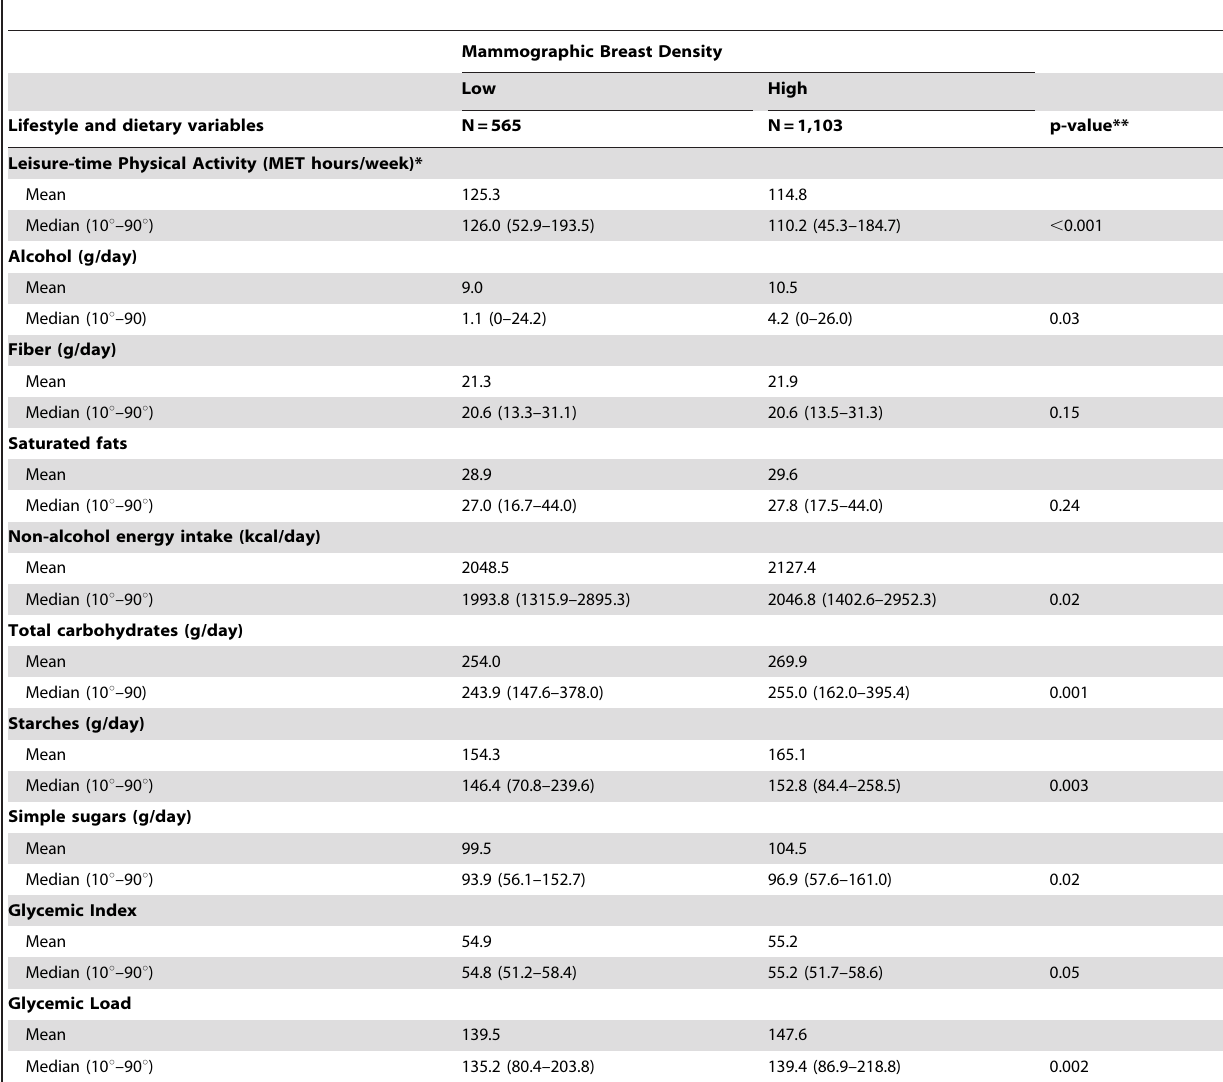
Table 2. Mean and median values of selected lifestyle and dietary variables of 1,668 participants by low and high MBD (EPIC-